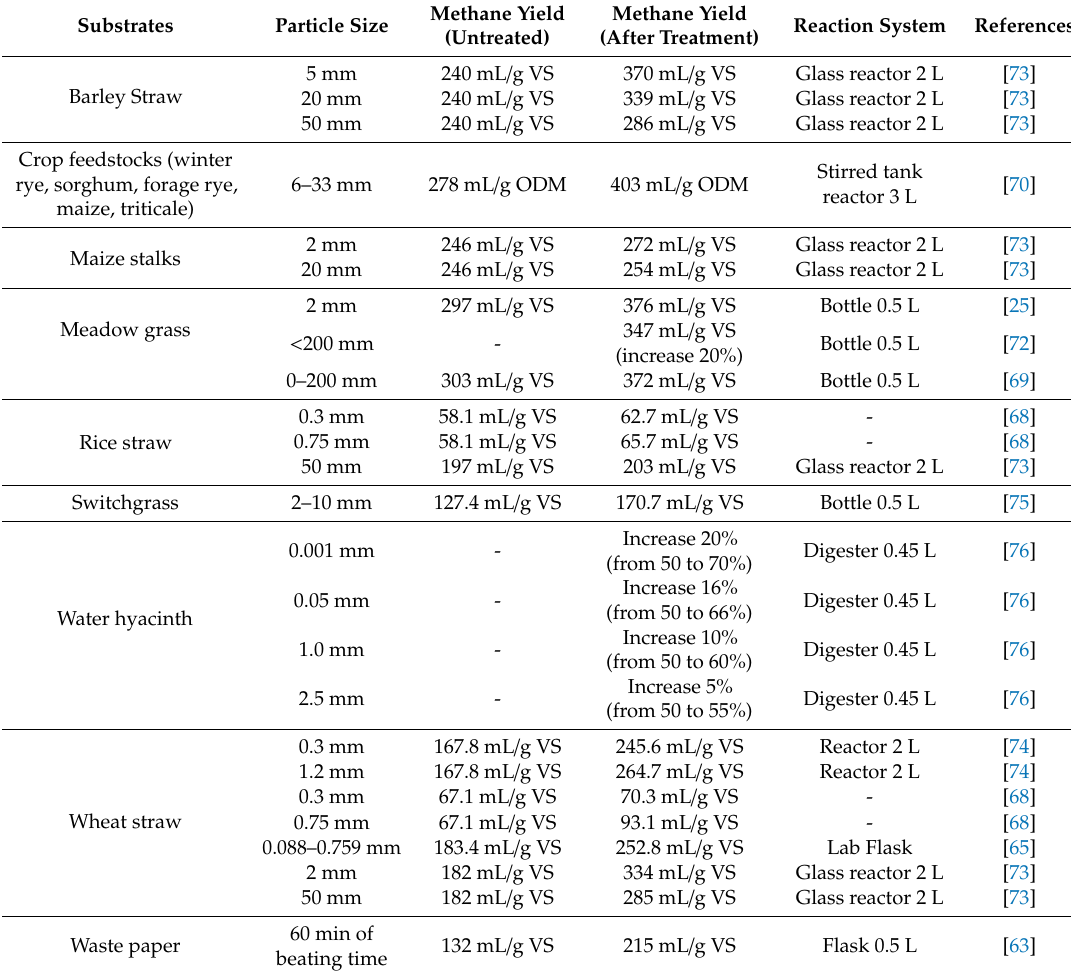
Table 3. E ff ect of mechanical pretreatments on methane yield from lignocellulosic